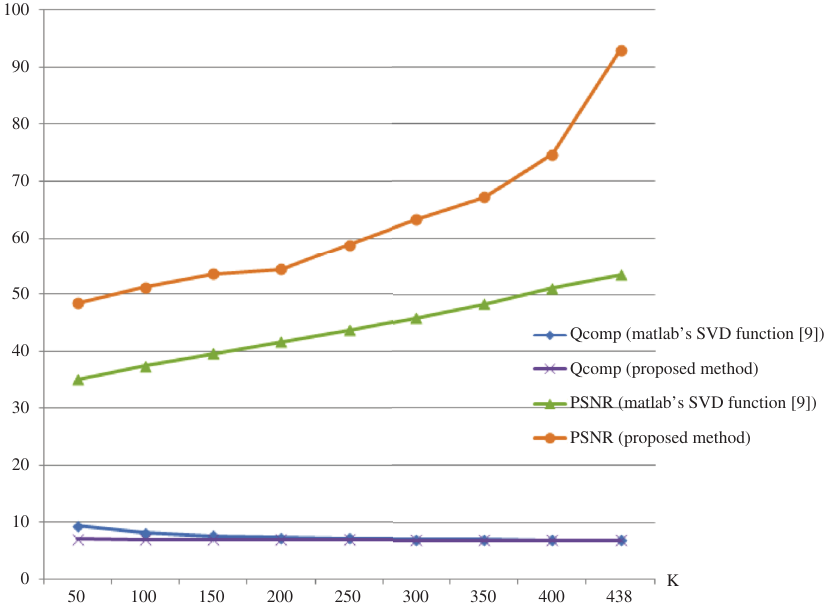
Figure 9: Relation between Image Rank, Compression Ratio, and PSNR for Desert.jpg, 1024 × 768,